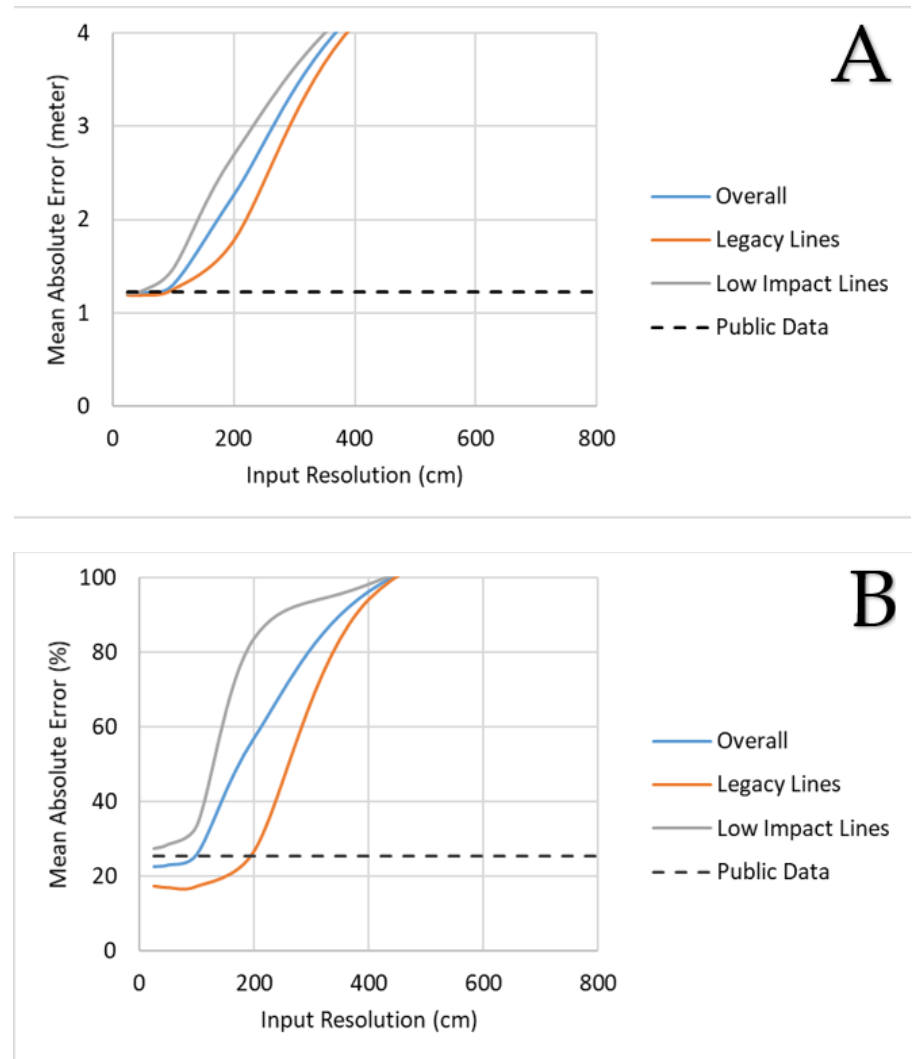
Figure 9. Mean absolute error (MAE) of predicted line width with reference to field-measured line width for different input CHM resolutions. Charts express errors in absolute units ( A ) and percentages relative to line width ( B ). Dashed lines show the accuracy of the best publicly available linear-feature datasets in our study sites. Note that while width-error levels could exceed the values presented